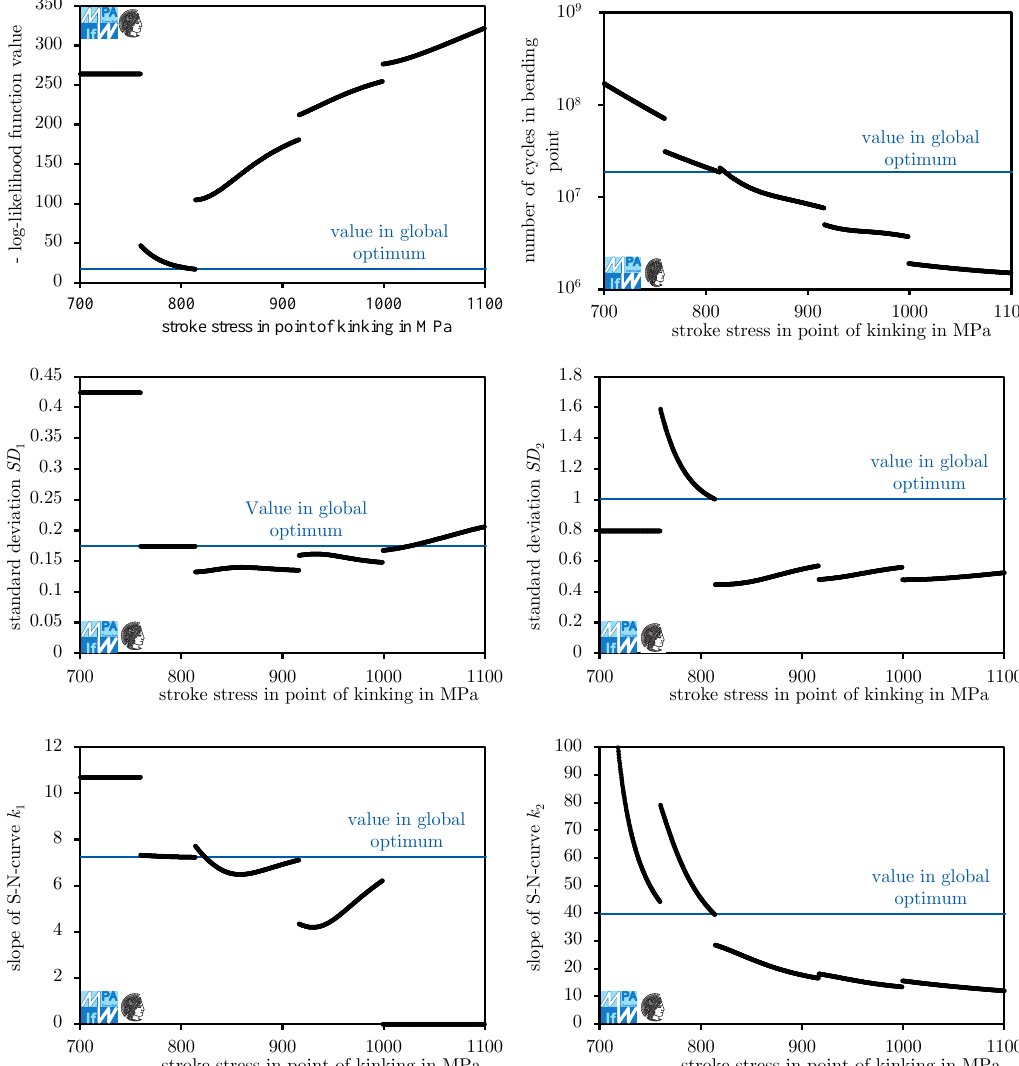
Figure 4. Likelihood function values and optimal parameters computed by optimizing maximum likelihood functions for fixed stresses (1000 points) and all other parameters optimized at the point of bending, τ kink